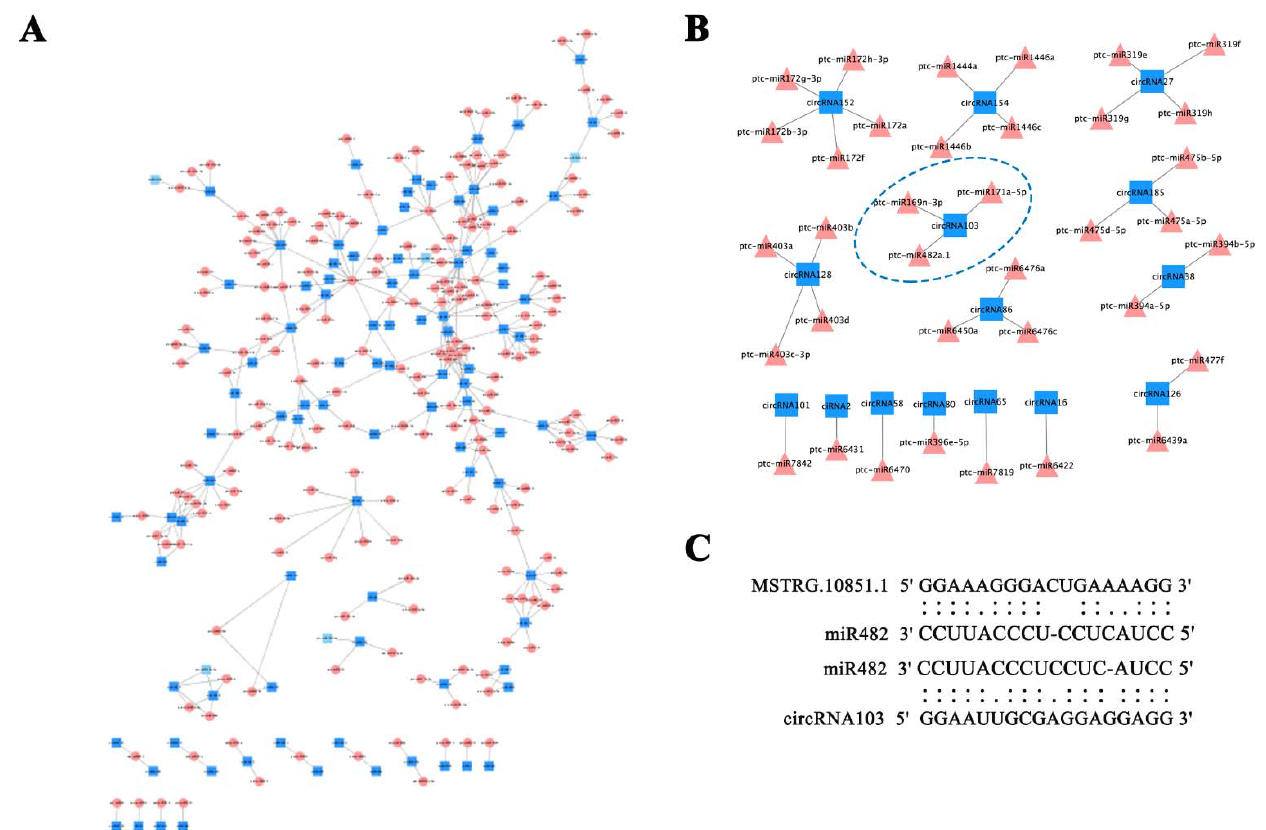
Figure 8. The circRNAs as miRNA targets. ( A ) lncRNAs and miRNAs with interaction networks. ( B ) CircRNAs targeted by miRNAs. ( C ) The interaction of circR103, miR482, and MSTRG.10851.1.